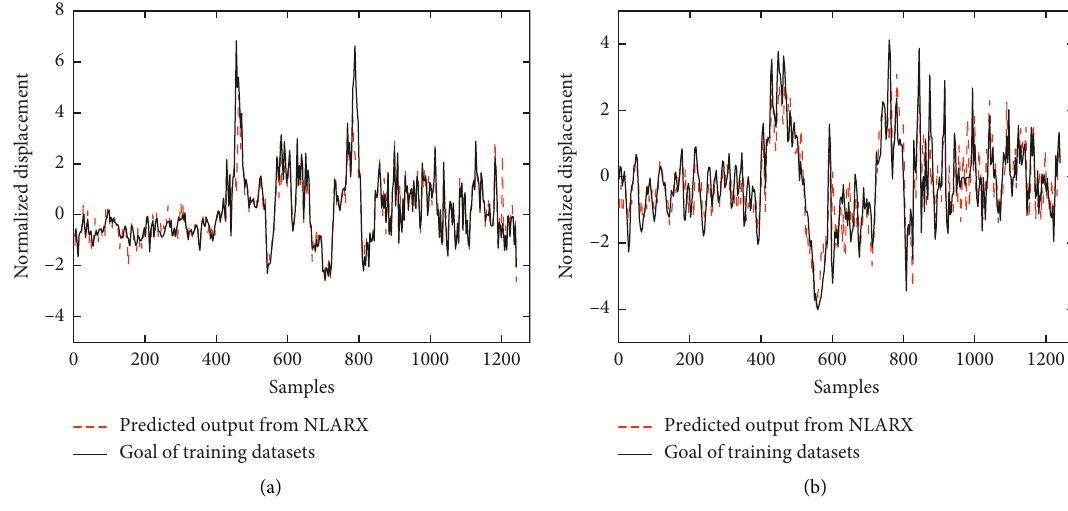
Figure 10: NLARX results for testing datasets: (a) left external loads; (b) right external